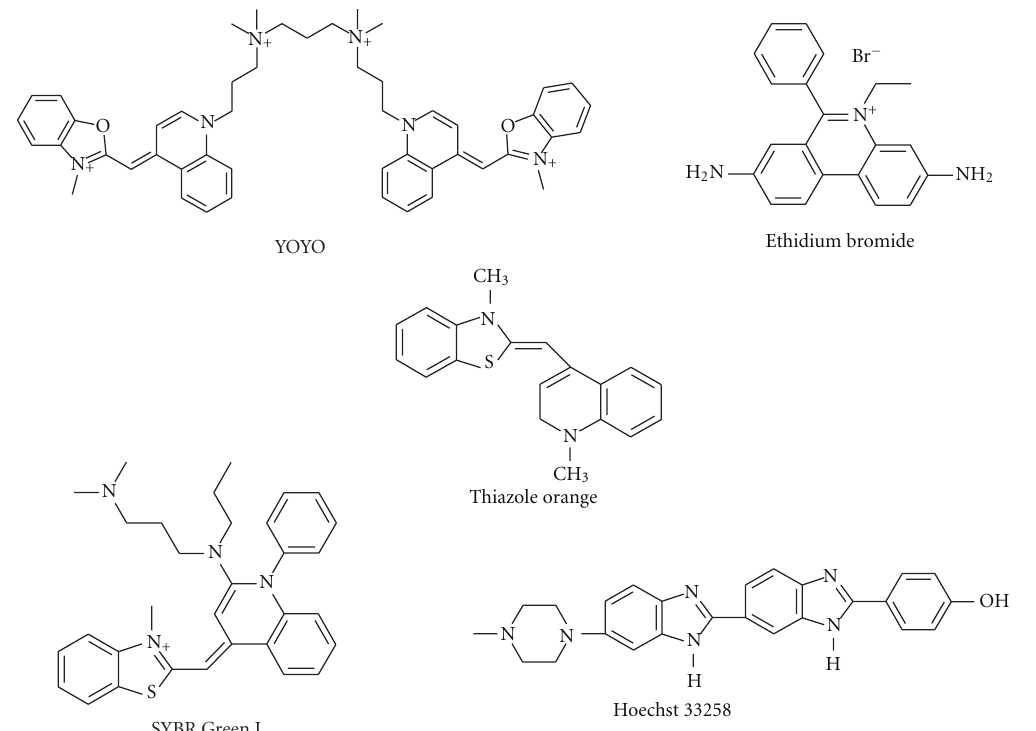
Figure 2: Nucleic-acid-binding chromophores used in current